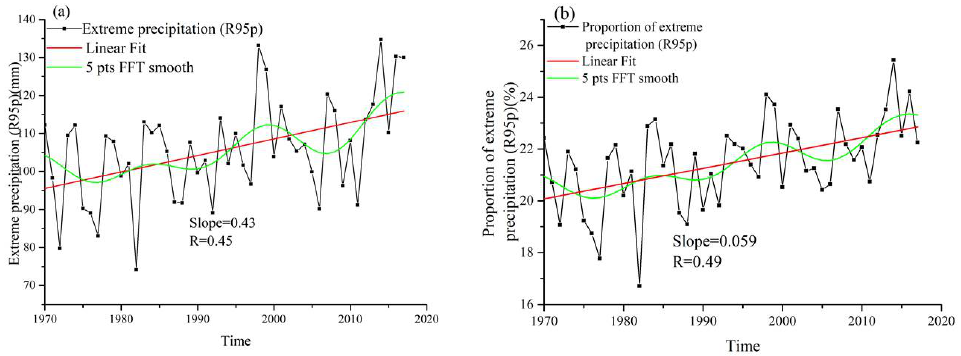
Figure 4. Changes in total extreme precipitation (R95p) ( a ) and extreme precipitation percentage change ( b ) in the TP and TPS during 1971–2017.The rate of increase was 4.3 mm/decade slope (0.43; R: 0.45; Figure 4a) for extreme precipitation, and the rate of increase was 0.59%/decade (slope: 0.0059; R: 0.49; Figure 4b) for extreme precipitation percentage.